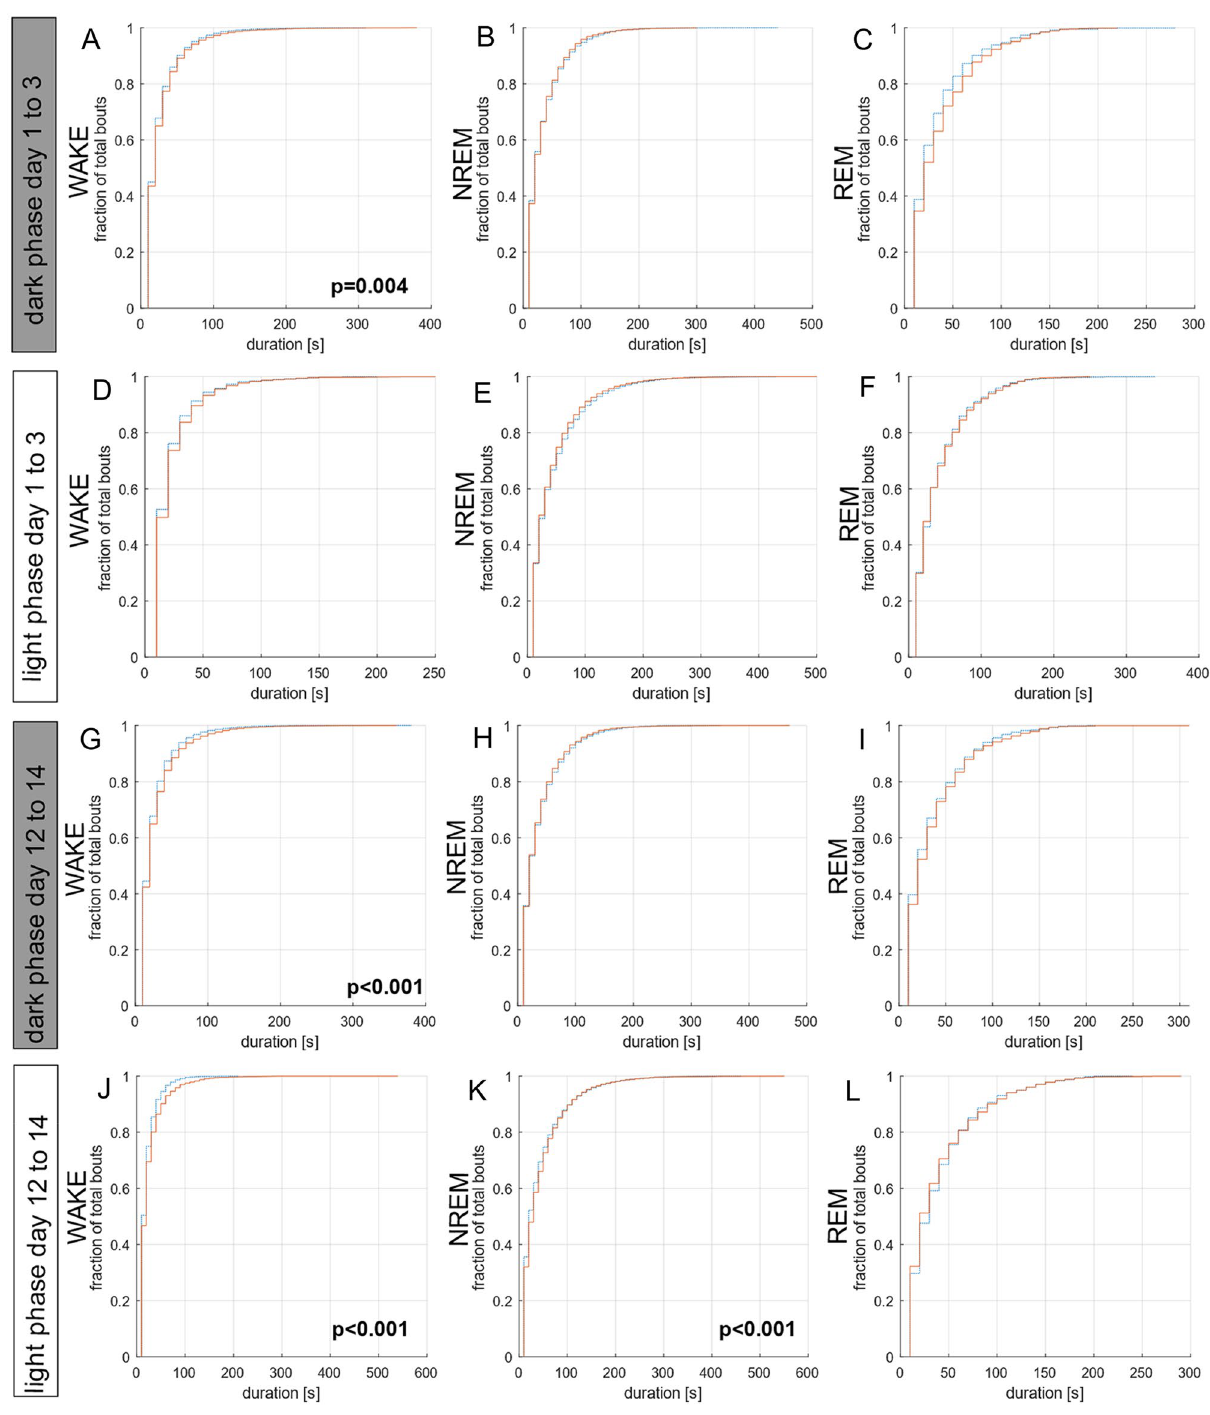
Figure 4. Bout length distribution of the vigilance states of the nontethered (broken blue lines, n = 6) and tethered (solid red lines, n = 7) animals pooled for dark phase and light phase. ( A – C ) Bout lengths of the dark phase at the beginning (first 3 days) of the experimental observation period for WAKE ( A ), NREM sleep ( B ) and REM sleep ( C ). Differences in the bout lengths for WAKE were detected (p = 0.004). ( D – F ) Bout lengths of the light phase at the beginning (first 3 days) of the experimental observation period for WAKE ( D ), NREM sleep ( E ) and REM sleep ( F ). ( G – I ) Bout lengths of the dark phase at the end (last 3 days) of the experimental observation period for WAKE ( G ), NREM sleep ( H ) and REM sleep ( I ). Differences in the bout lengths for WAKE were detected (p < 0.001). ( J – L ) Bout lengths of the light phase at the end (last 3 days) of the experimental observation period for WAKE ( J ), NREM sleep ( K ) and REM sleep ( L ). Differences in the bout lengths for WAKE (p < 0.001) and NREM (p < 0.001) were detected. Differences between the groups were tested using the Kolmogorov–Smirnov test and cumulative probability